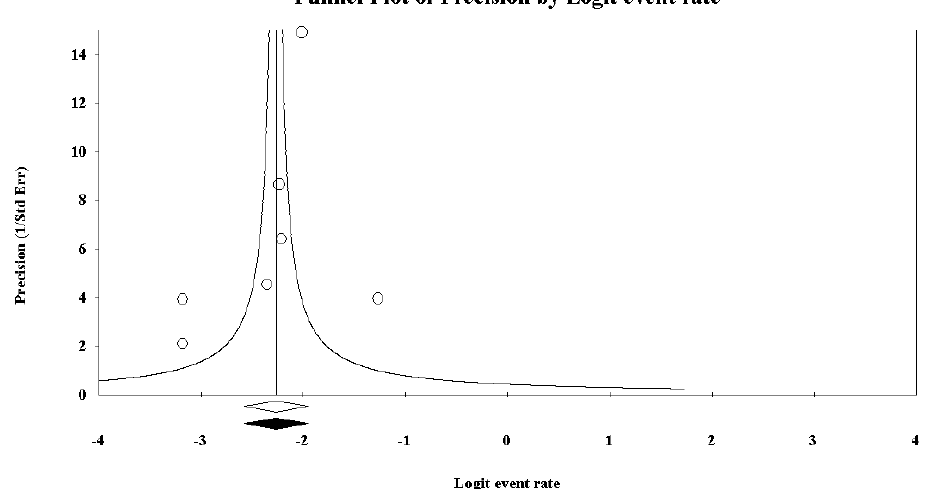
Figure 7. Funnel plot for “everyday drinking” consumption rate among truck-drivers, showing no evidence of publication bias. Table 7. Duval and Tweedie’s trim-and-fill analysis for “everyday drinking” consumption rate among truck drivers.